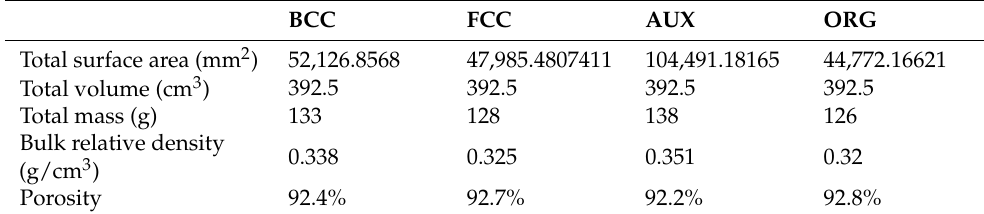
Table 5. Summary of geometric properties of lattice models.